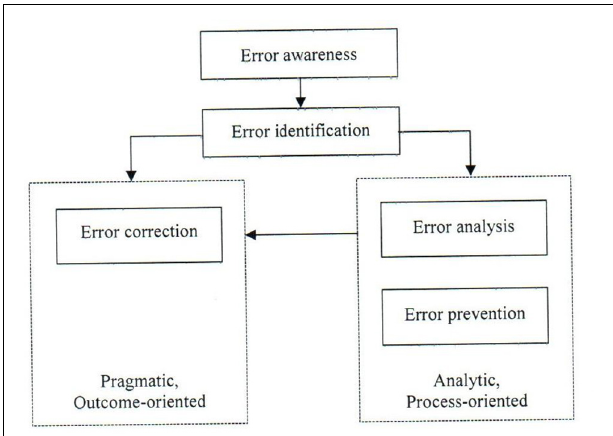
FIGURE 1 | The model for learning from errors [adapted from Rach et al. (2012), p.